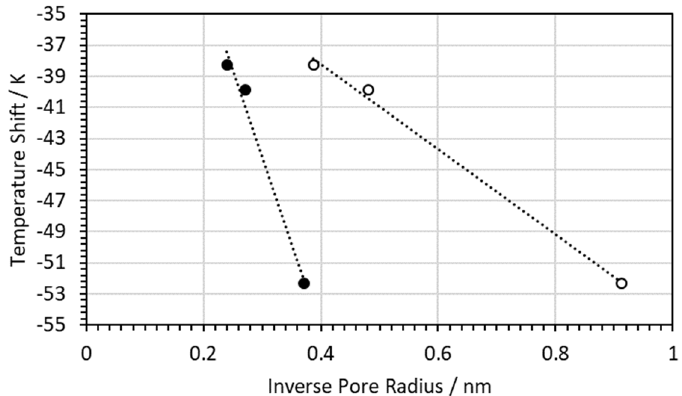
Figure 2. Gibbs–Thomson plots of Δ𝑇 vs. 1/𝑟 (filled circles) and Δ𝑇 vs. 1/(cid:4666)𝑟 − 𝑡(cid:4667) (open circles). Linear regressions are ∆ T = − 110.87 Linear regressions are Δ𝑇 = − (cid:2869)(cid:2869)(cid:2868).(cid:2876)(cid:2875) R 2 = = 0.9965.